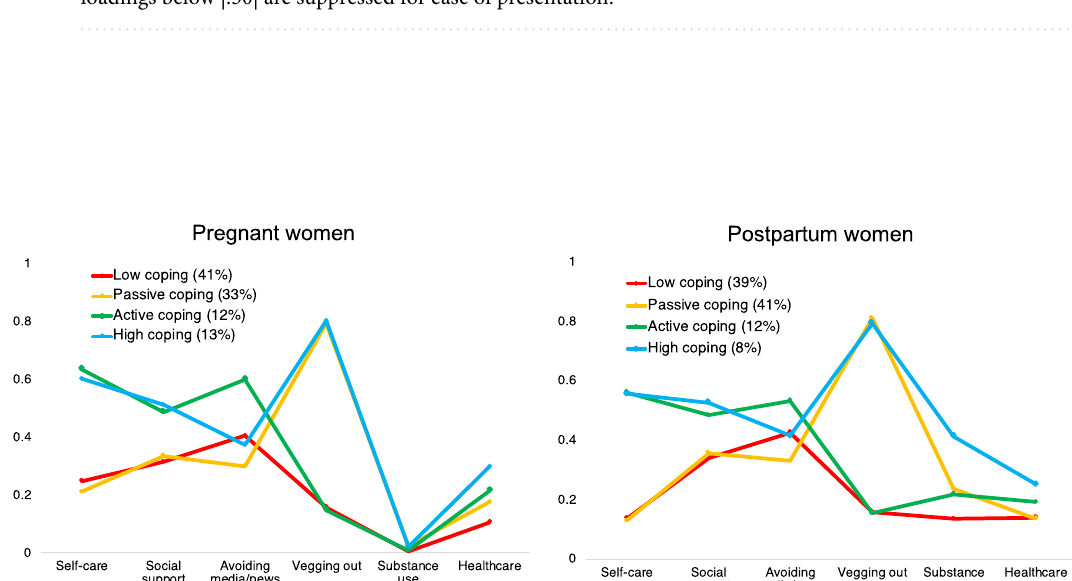
Table 2. Principal components analysis structure matrix and factor correlations. N = 4,412. Component loadings below |.30| are suppressed for ease of presentation.